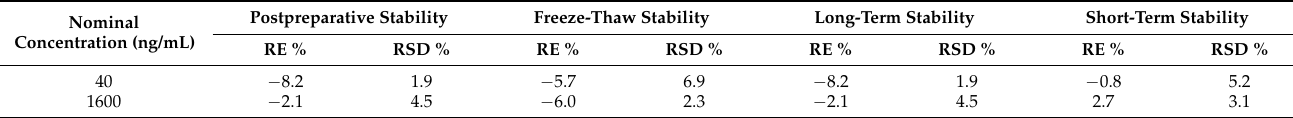
Table 3. Stability of gatifloxacin in the cornea ( n = 3).